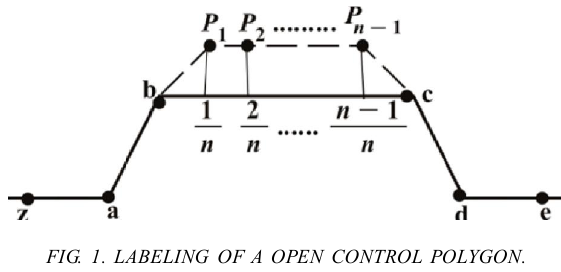
FIG. 1. LABELING OF A OPEN CONTROL POLYGON.